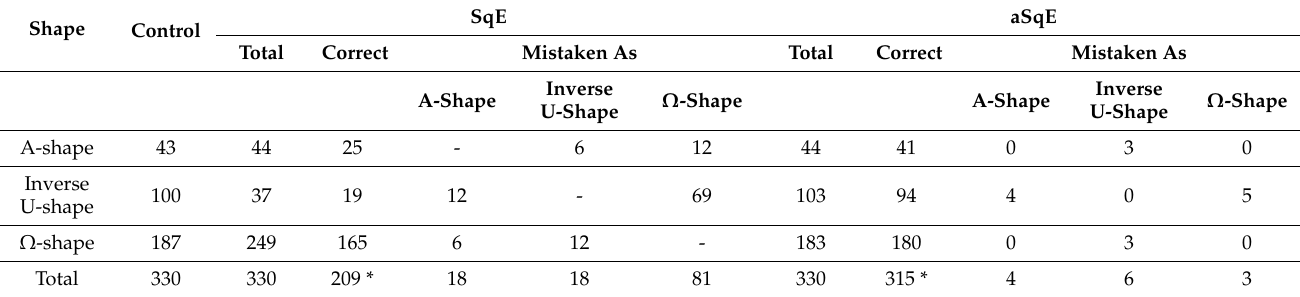
Table 2. Comparison of semi-quantitative evaluation (SqE) and assisted semi-quantitative evaluation (aSqE) with calculated control. Note the significant difference between the results of SqE and aSqE